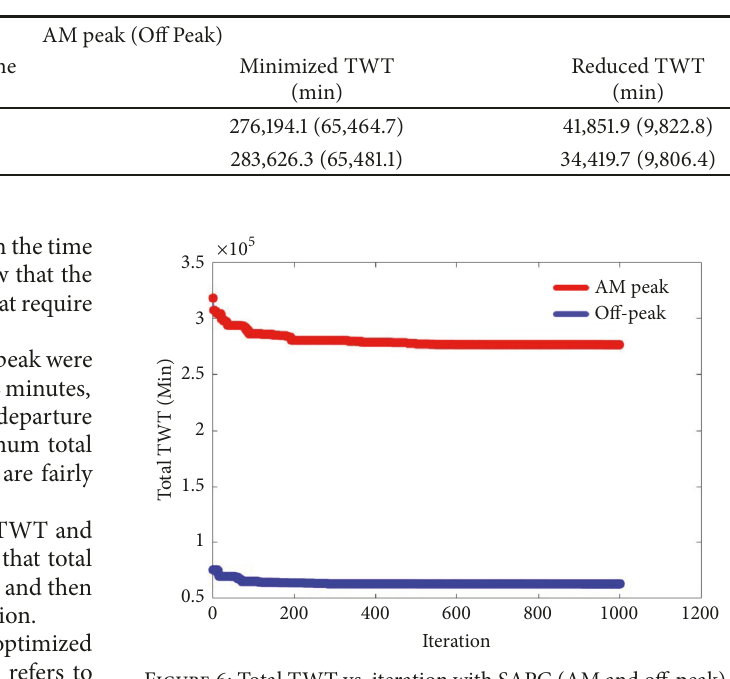
Figure 6: Total TWT vs. iteration with SAPC (AM and